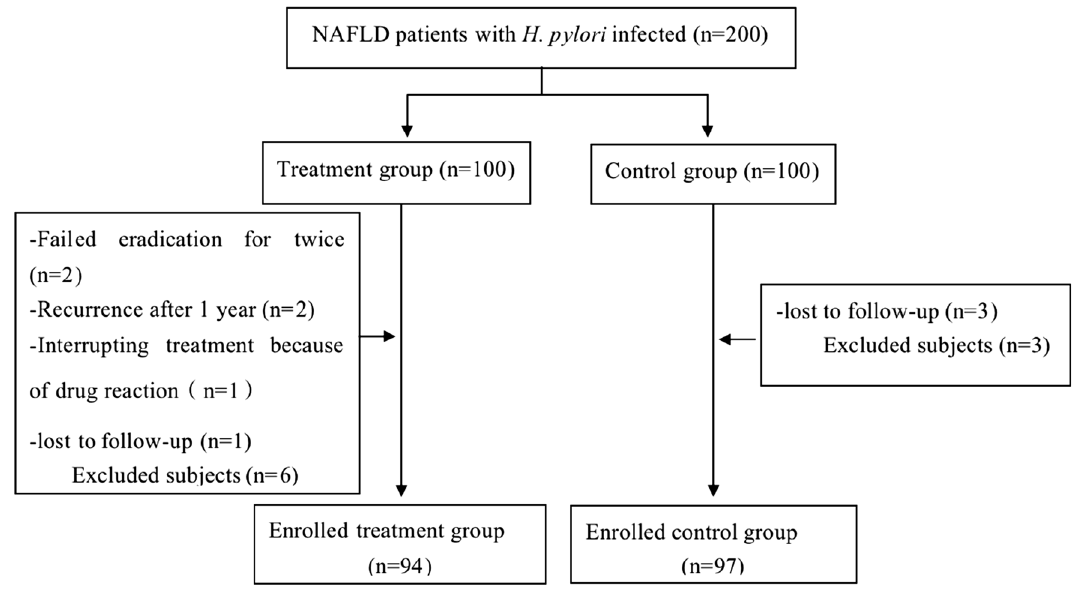
Figure 1. Flow diagram depicting the